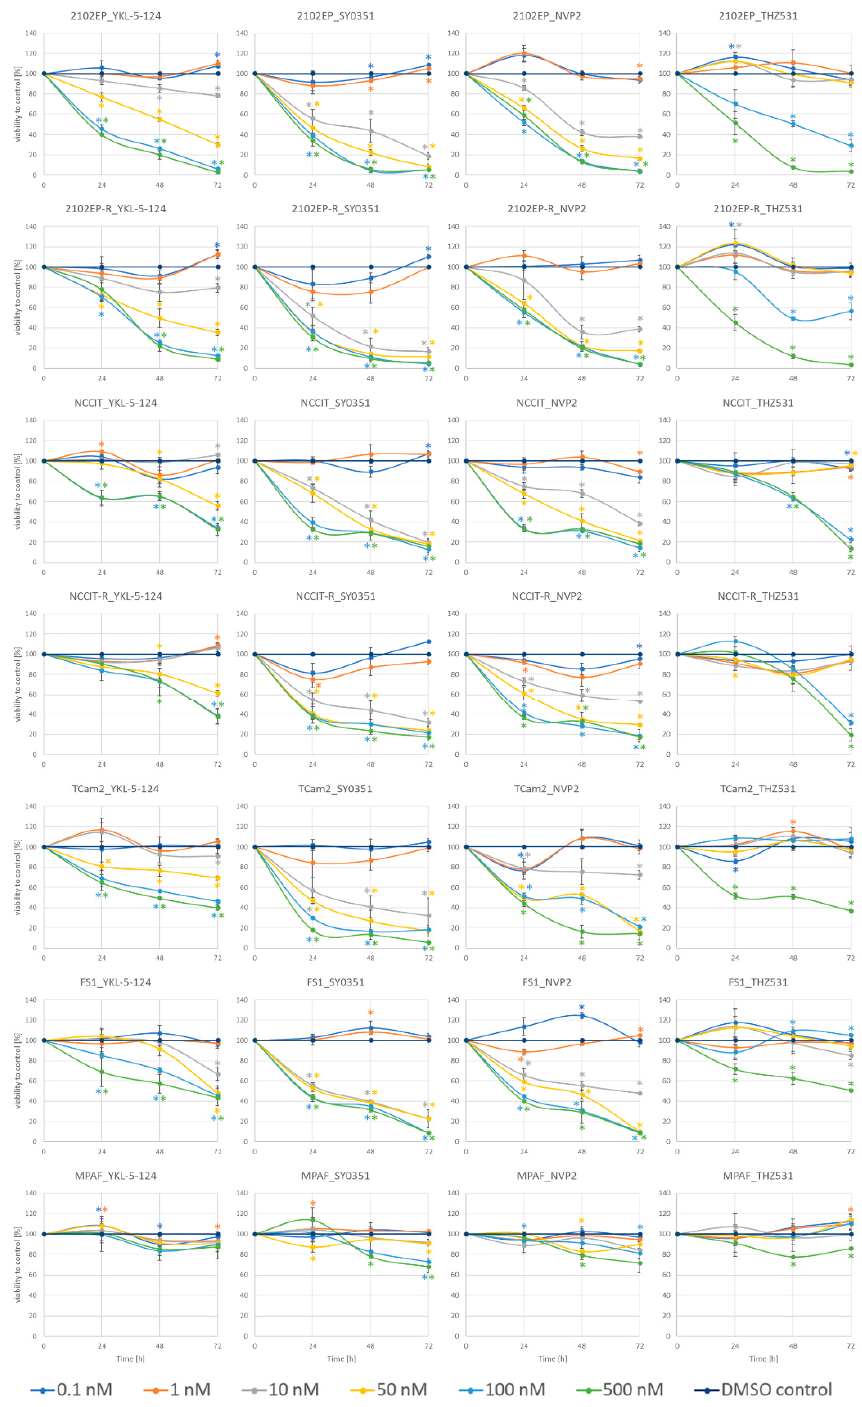
Figure 2. Viability of wild-type and cisplatin-resistant TGCT cell lines after treatment with CDK inhibitors (YKL-5-124, SY0351, NVP2, THZ531). Measurement of viability by XTT assay after single application of CDK inhibitor at 24, 48 and 72 h. DMSO control was applied in all indicated concentrations and referred to as 100% viability. Asterisks indicate significant change in viability between treated and control cells (* p < 0.05). Asterisks color code indicate corresponding CDK concentration. n = 3–7. The EC cell lines (2102EP, 2102EP-R, NCCIT, NCCIT-R) seemed to be highly sensitive to dinaciclib and flavopiridol, indicated by a strong decrease in viability at concentrations